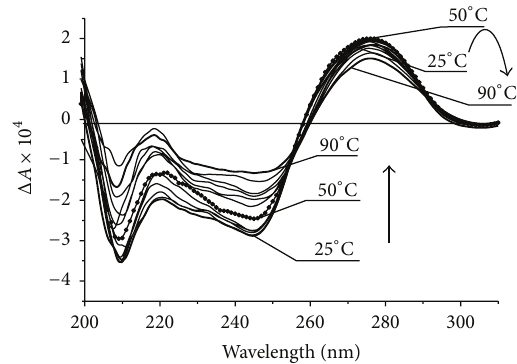
Figure 3: Circular dichroism spectra of the HMGB1/DNA complex obtained at different temperatures in the range of 20–90 ∘ C. The con- centration of DNA in sample was 30 𝜇 g/mL, and the concentration of HMGB1 was 15 𝜇 g/mL. The complexes were prepared in 0.25 mM EDTA/0.2 mM NaCl solution. The optical path length was 1cm.